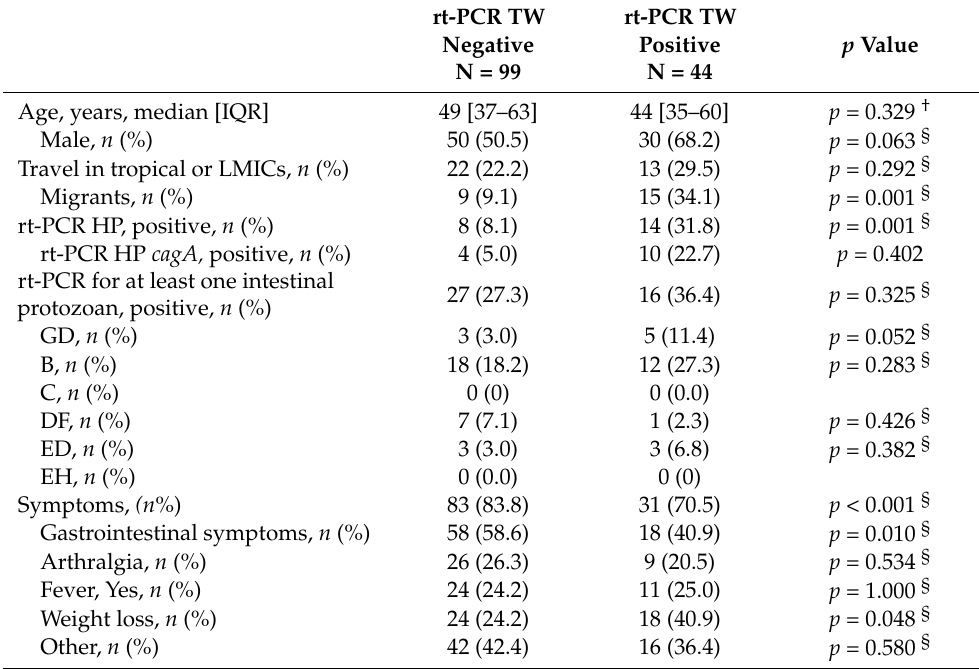
Table 2. Demographic data, risk factors, rate of infections (HP and protozoa), and symptoms of 143 patients, according to the results of the rt-PCR for TW. TW, T. whipplei ; HP, H. pylori ; GD, G. duodenalis ; B, Blastocystis spp. ; C, Cryptosporidium spp. ; DF, D. fragilis ; ED, E. dispar ; EH, E. histolytica ; LMICs, low- and middle-income countries; IQR, interquartile range. rt-PCR TW rt-PCR TW p Value Positive Negative N = 44 N = 99 Age, years, median [IQR] 49 [37–63] p = 0.329